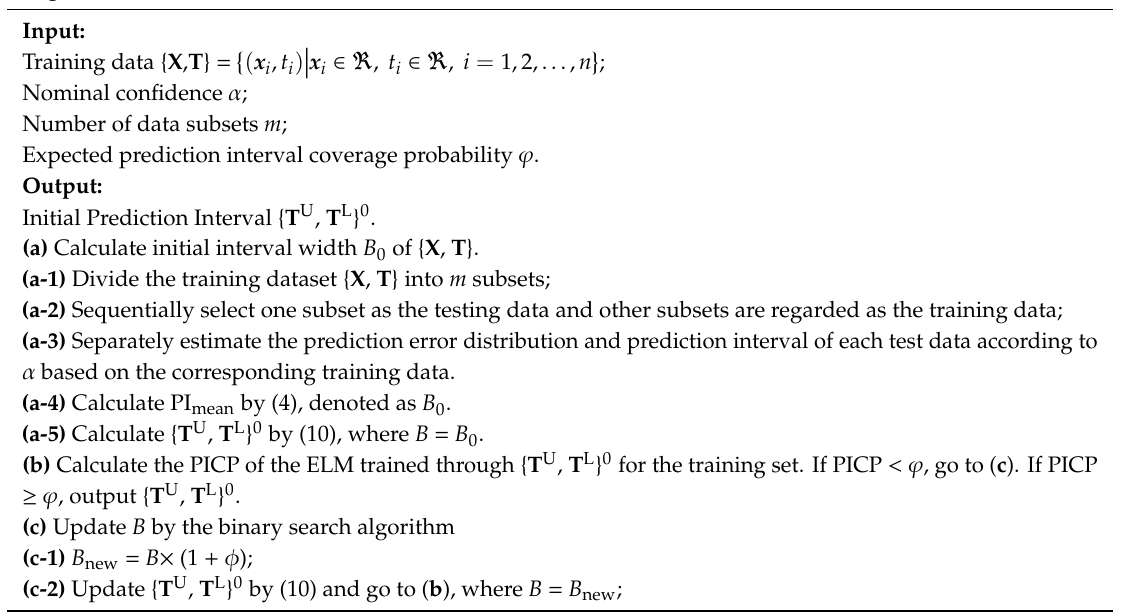
Algorithm 1 Prediction Interval Width Initialization